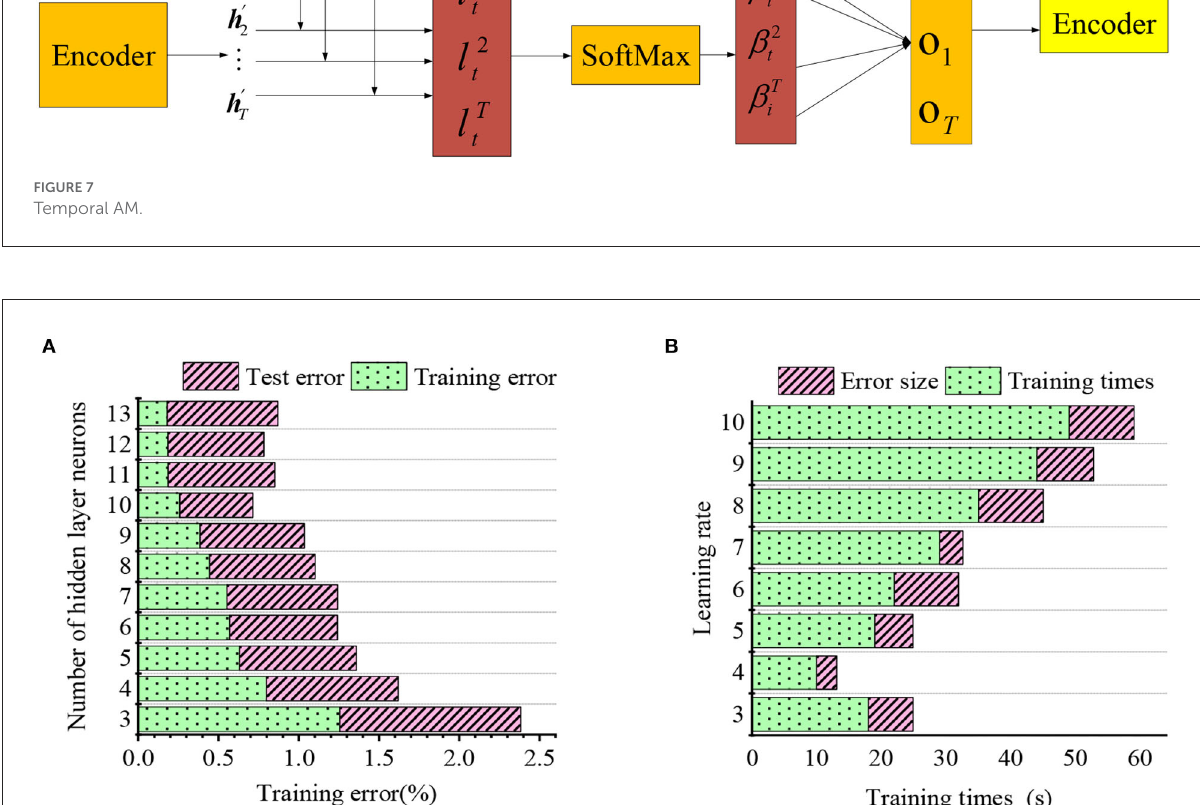
FIGURE8 Relationship between the hidden layer neurons, the learning rate, and model error. (A) Indicates the relationship between the hidden layer neurons and error. (B) Shows the relationship between the learning rate and model error.